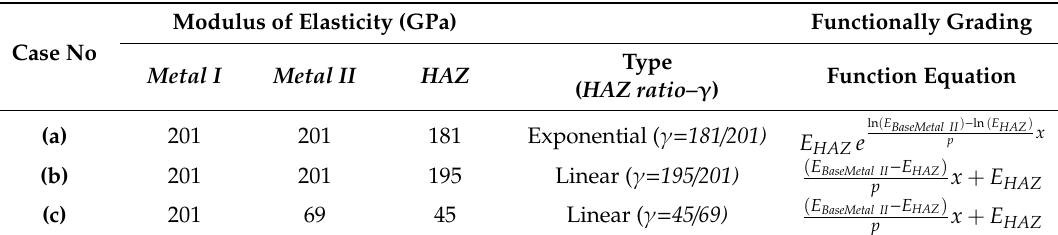
Table 3. Modulus of elasticity of di ff erent functionally graded cases.